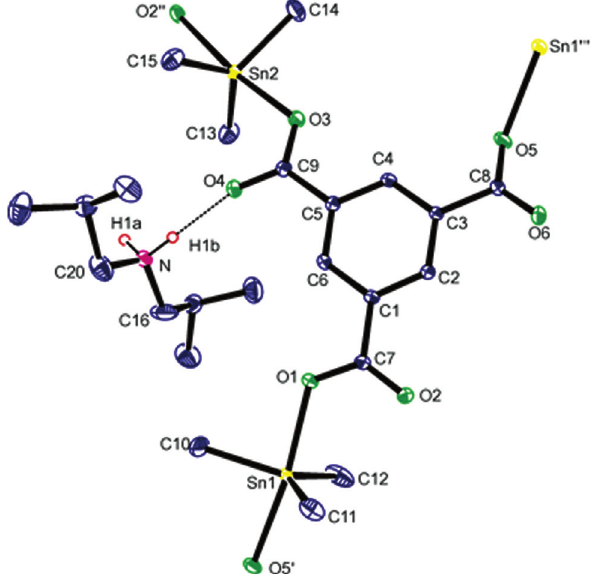
Figure 3 The asymmetric unit of compound 2 ; only the major com- ponent of the disordered cation is shown for